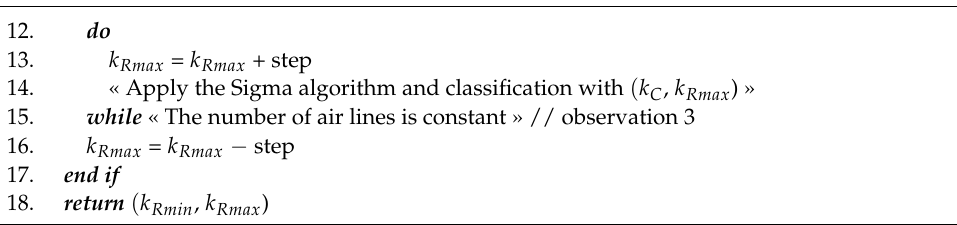
Algorithm 3 Tuning algorithm for the k r parameter.